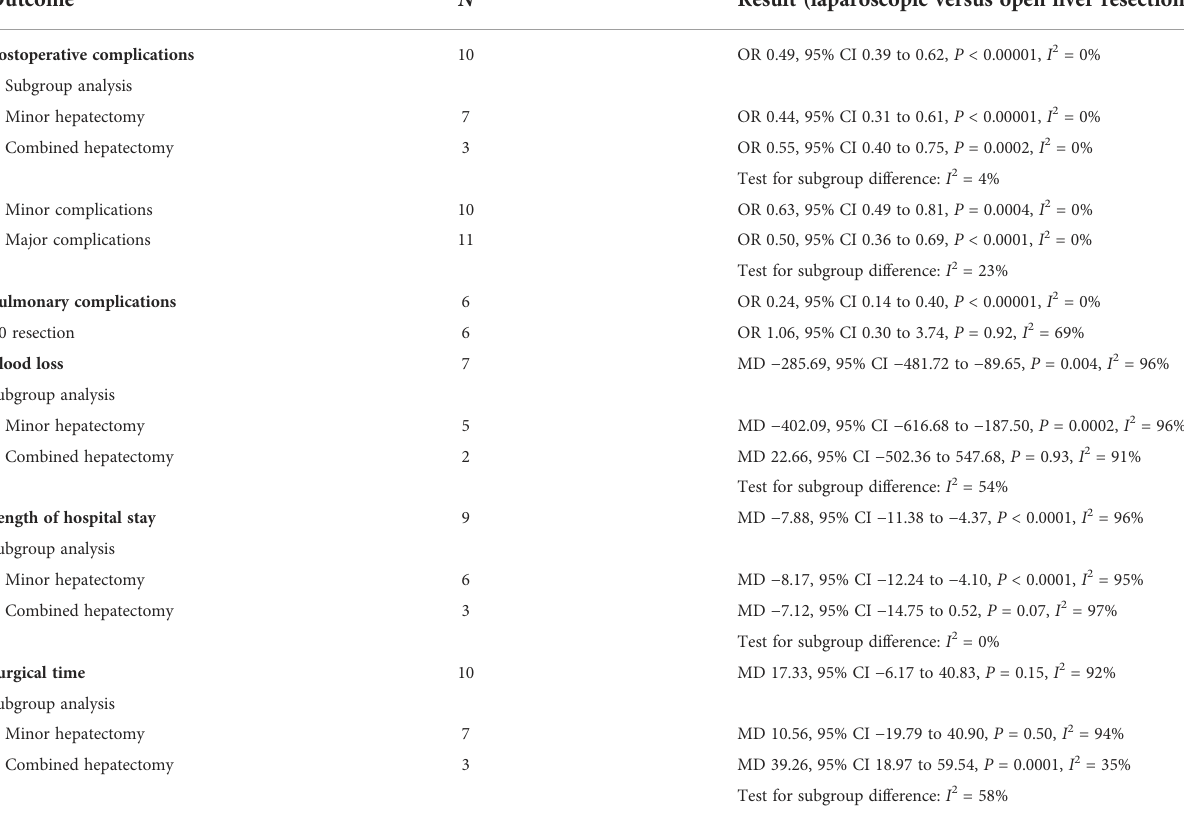
TABLE 3 Results of this